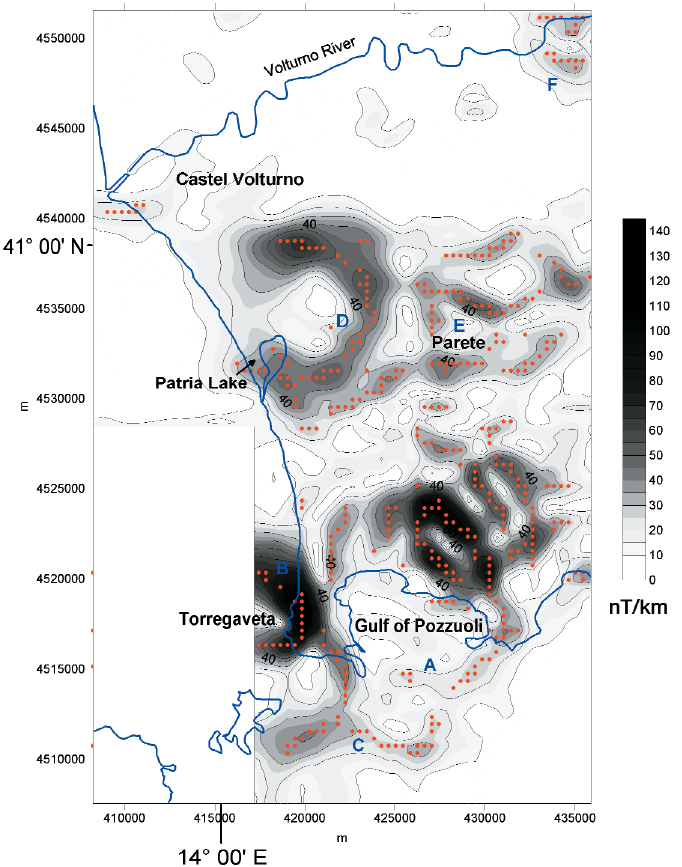
Fig. 10. Map of the Horizontal Derivative plotted in a gray scale. The main maxima of the function are indi- cated by red